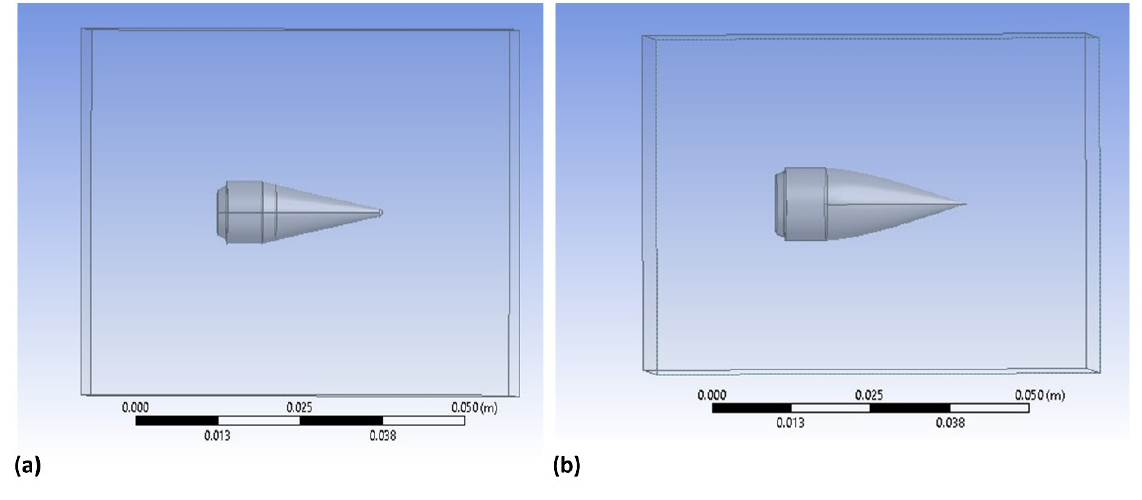
Figure 5. Geometric enclosure of ( a ) design I and ( b ) design II of the bullet head in Ansys soft- ware.